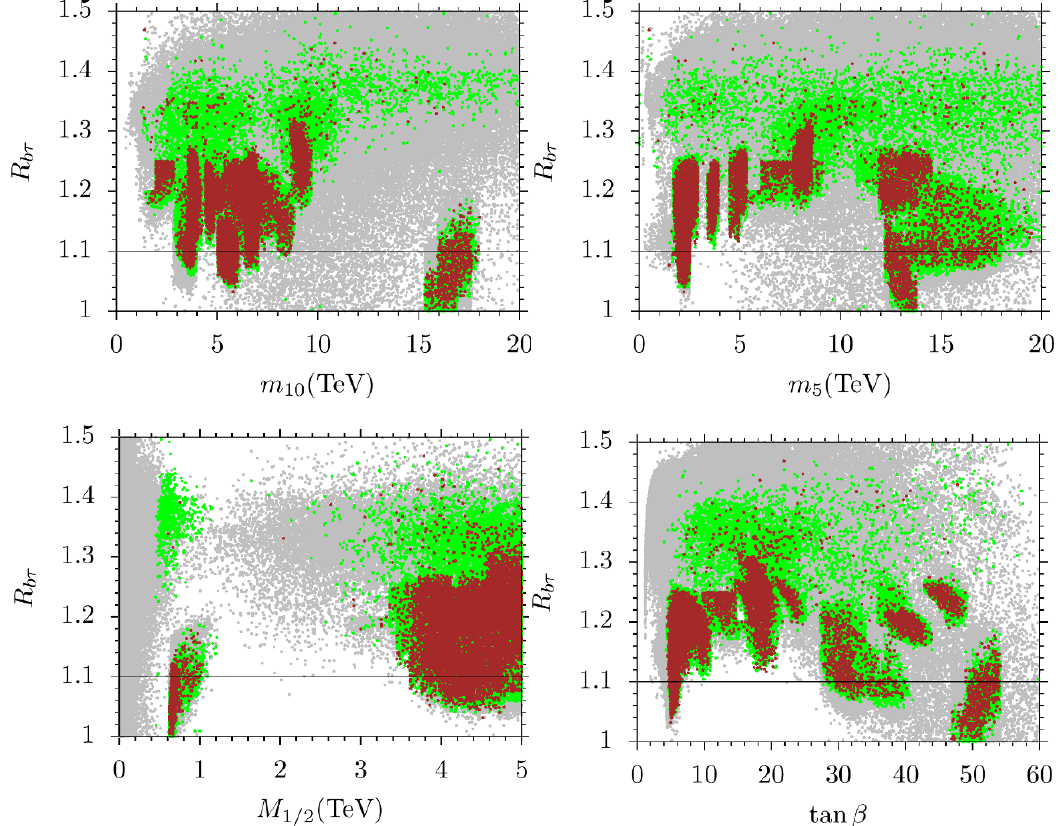
Figure 1 . Plots in the R b(cid:28) (cid:0) m 10 , R b(cid:28) (cid:0) m 5 , R b(cid:28) (cid:0) M , and R b(cid:28) (cid:0) tan (cid:12) planes. All points are 1 = 2 consistent with the REWSB and LSP neutralino LSP conditions. Green points satisfy the mass bounds and the constraints from rare B (cid:0) meson decays. Brown points are a subset of green, and they are compatible within 5 (cid:27) with the WMAP bound on the relic density of the LSP neutralino. The horizontal line indicates the regions yielding R b(cid:28) = 1 : 1, below which lie the solutions most consistent with the b (cid:0) (cid:28) YU